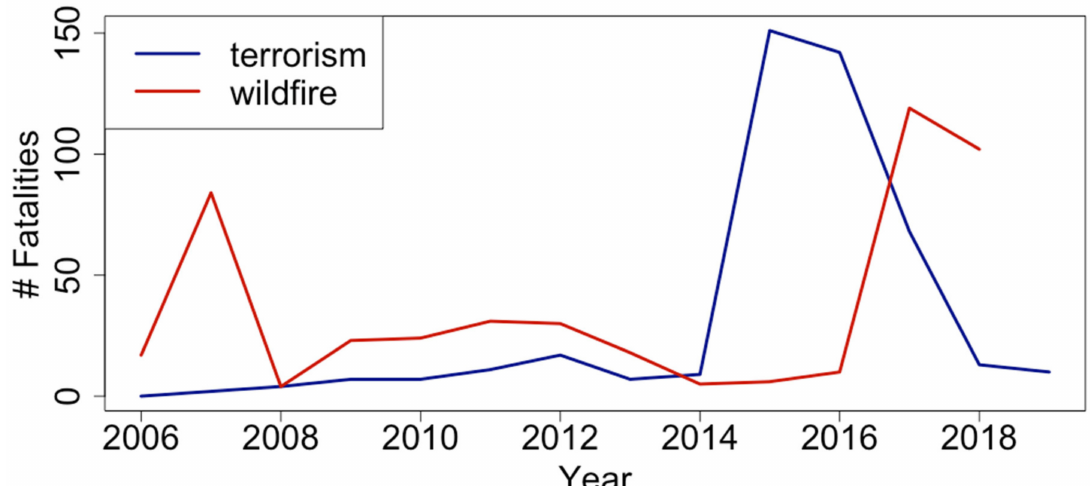
Figure 1. The number of fatalities resulting from wildfires is now larger than the number of terrorism victims in the European Union. We compiled data on people killed by terrorism in the EU since Europol TE-SAT reports [15] started in 2006 with data on wildfire fatalities for Southern Europe (Portugal, Spain, Greece, and Sardinia)